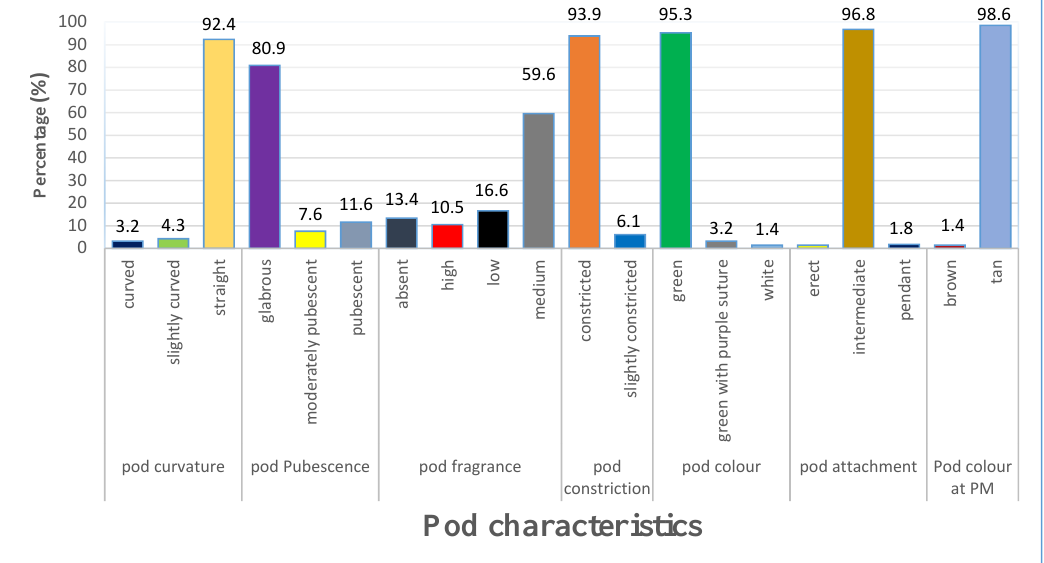
Green colour (99.6%) was dominant over purple coloration (0.4%) in relation to freshly harvested seeds. Oval seed shape made up the majority of the dry seed (92.8%), with 7.2% being round seeded. Black (26.7%), white (20.2%), cream (19.5%), and brown (0.4%) were the most prevalent dry seed colors (Figure 4). Selected qualitative characters are shown visually as in Figure 5. Figure 4. Variation in seed characters of lablab accessions.